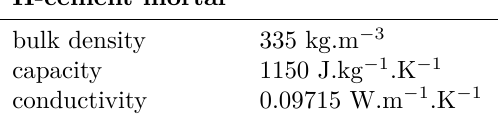
Table 3. H-cement material parameters with con- ductivity yielding from the